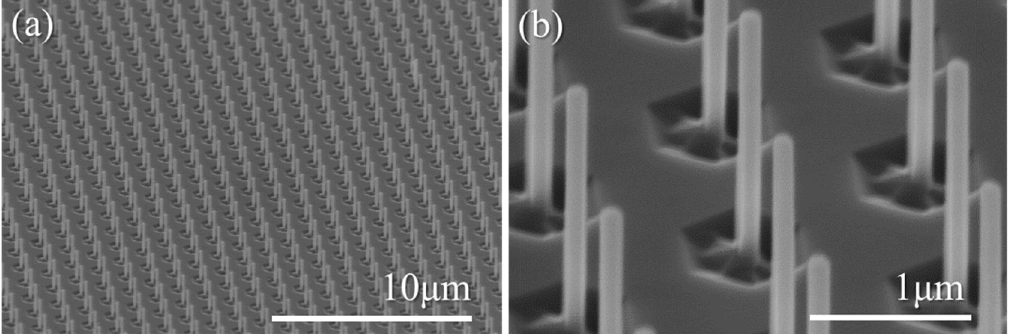
Figure 2. ( a ) Low and ( b ) high magnification, tilted, secondary-electron SEM images of the AlN nanorod arrays after the two-step dry-wet etching process and metal mask removal.